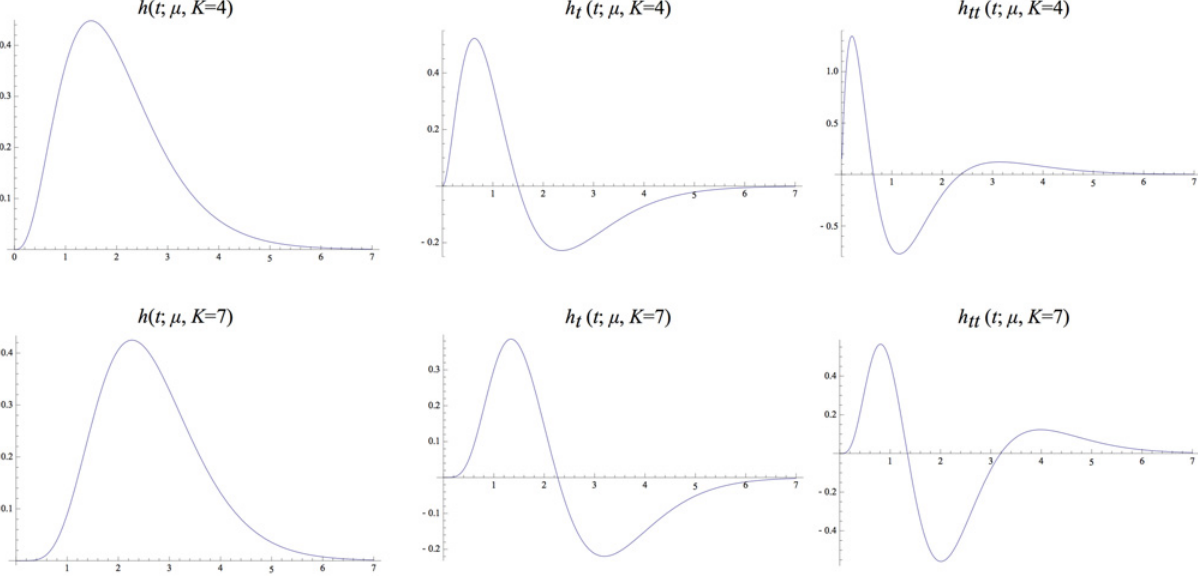
Fig 4. Equivalent kernels h kernels with equal time constants μ and their first- and second-order derivatives. (top row) k = 4 and m ¼